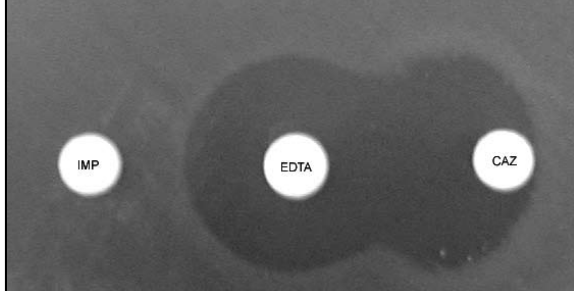
Figura 4 – Amostra clínica apresentando teste fenotípico positivo para a produção de MßL. O teste demonstra a distorção e a ampliação do halo de inibição do crescimento da bactéria testada na região do ágar onde houve a difusão do agente quelante (EDTA)